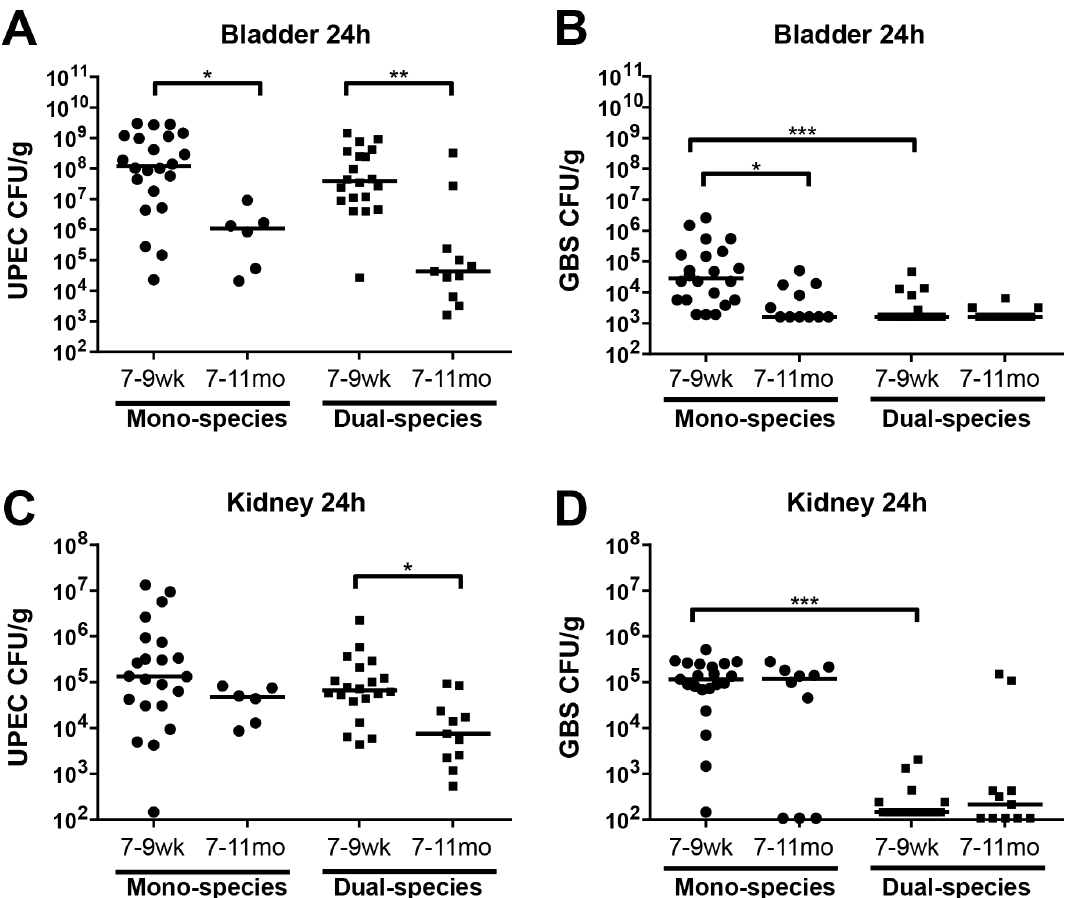
Figure 1. Age-associated risk factors for UTI in nulliparous virgin hosts. Organ weight-adjusted bladder CFU for UPEC ( A ) and GBS ( B ), and kidney CFU for UPEC ( C ) and GBS ( D ) at 24 hours post infection of C3H/HeN female mice with , 10 7 UPEC UTI89 alone or with , 10 7 GBS COH1 in UPEC + GBS mixed inoculation. N=1–4, at least 5 mice per experiment, where N indicates the number of biologically distinct experiments performed (N=4 for 7–9wk groups, N=1 for UPEC mono-infected 7–11mo group, and N=2 for GBS mono-infected and all dual-infected 7–11mo groups). Recovered titers of zero were set to the limit of detection of the assay for statistical analyses and graphical representation in all figures. The horizontal bar represents the median value for each group of mice. Statistical significance was determined by the Kruskal-Wallis test with Dunn’s post-test for multiple comparisons. * P , 0.05, ** P , 0.005, *** P , 0.0005.